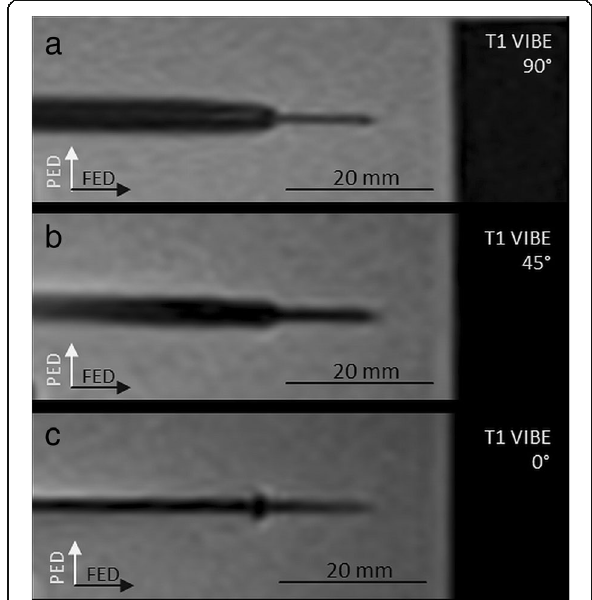
Fig. 3 Artefact of the microwave applicator. Images are acquired under 90° applicator angulation relative to B 0 with T1W-VIBE ( a ), T1W-FLASH ( b ), and T2W-TSE ( c ) (see text for sequence details). For all sequences, the applicator shows a similar artefact pattern with a prominent artefact at the shaft ( A shaft ) and a smaller artefact at the tip ( A tip ). PED Phase encoding direction, FED Frequency encoding direction